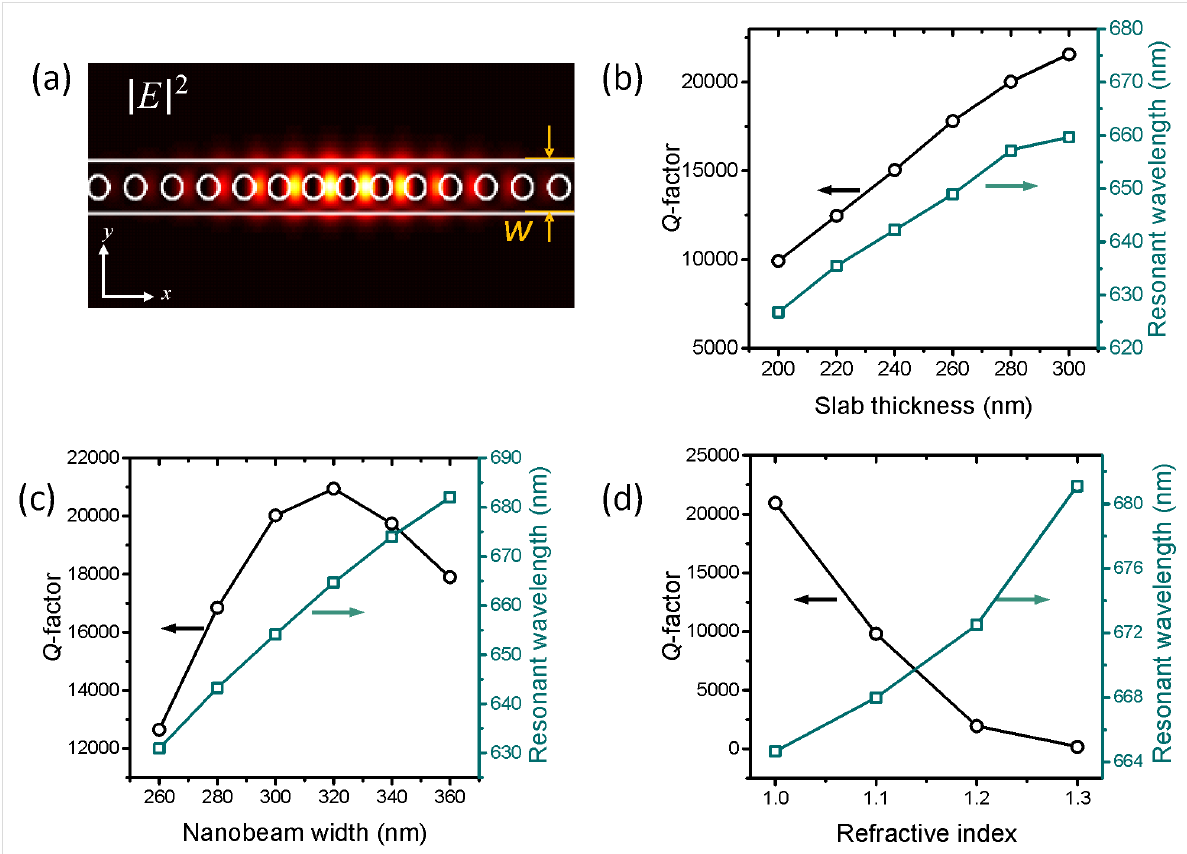
Figure 3: (a) Calculated electric field intensity distribution for a 1D photonic crystal cavity. 3D FDTD simulation of Q -factor versus (b) slab thickness, (c) nanobeam width ‘ w ’, and (d) refractive index of the substrate, respectively.